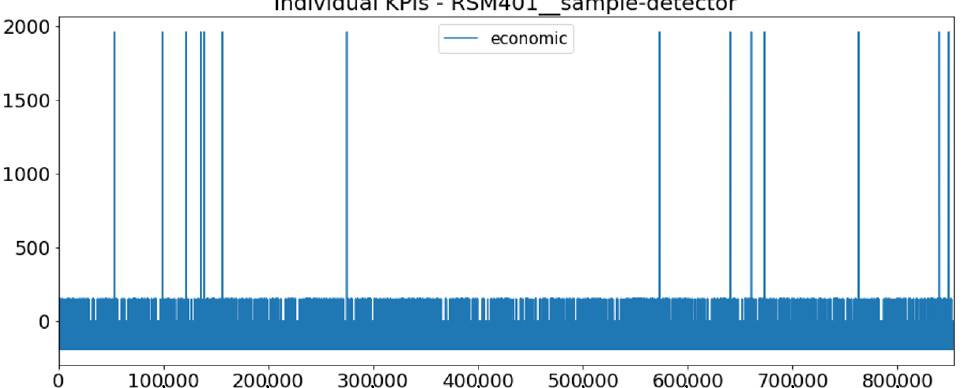
Figure 12. KPI time series for the sample-detector yielded from running the model for the friction welding machine (HWH). The simulation interval has the same length as for training (292